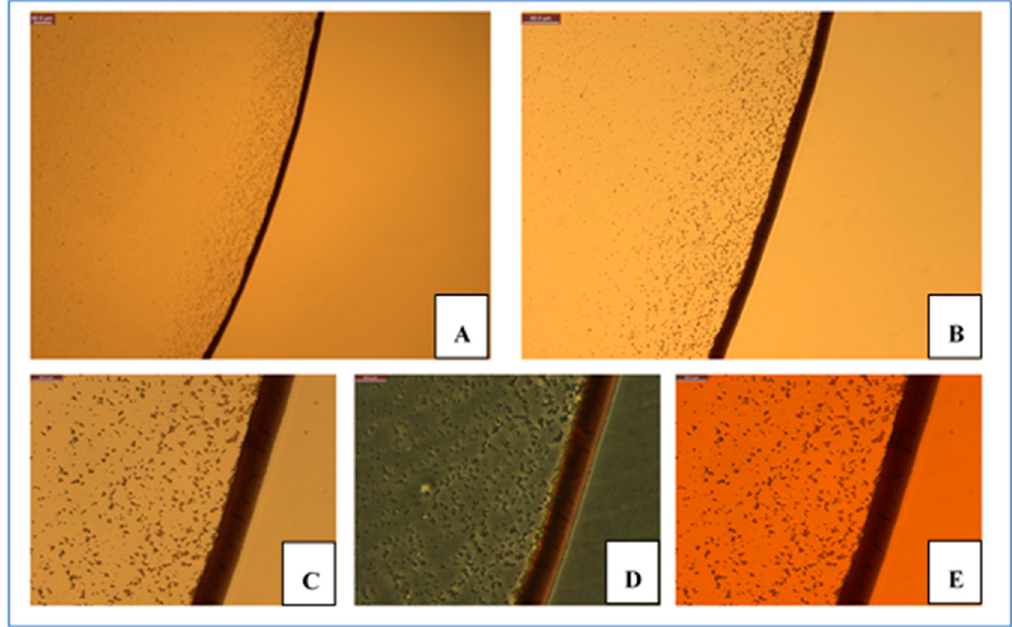
Figure 5. Microscopy characterization of AgCysNP dried films. Nanofilms were prepared as described in methods. Nanoparticles formed a distinct coffee-ring effect as shown under white-light microscopy using 10× and 20× objectives ( A , B , respectively). Zoomed portions of the dried films were further characterized using bright-field, polarization, and phase microscopy (panels C – E , respectively). Scale bars in upper left of each image indicate 50 microns for panels A , B ; and 20 microns for panels C – E .